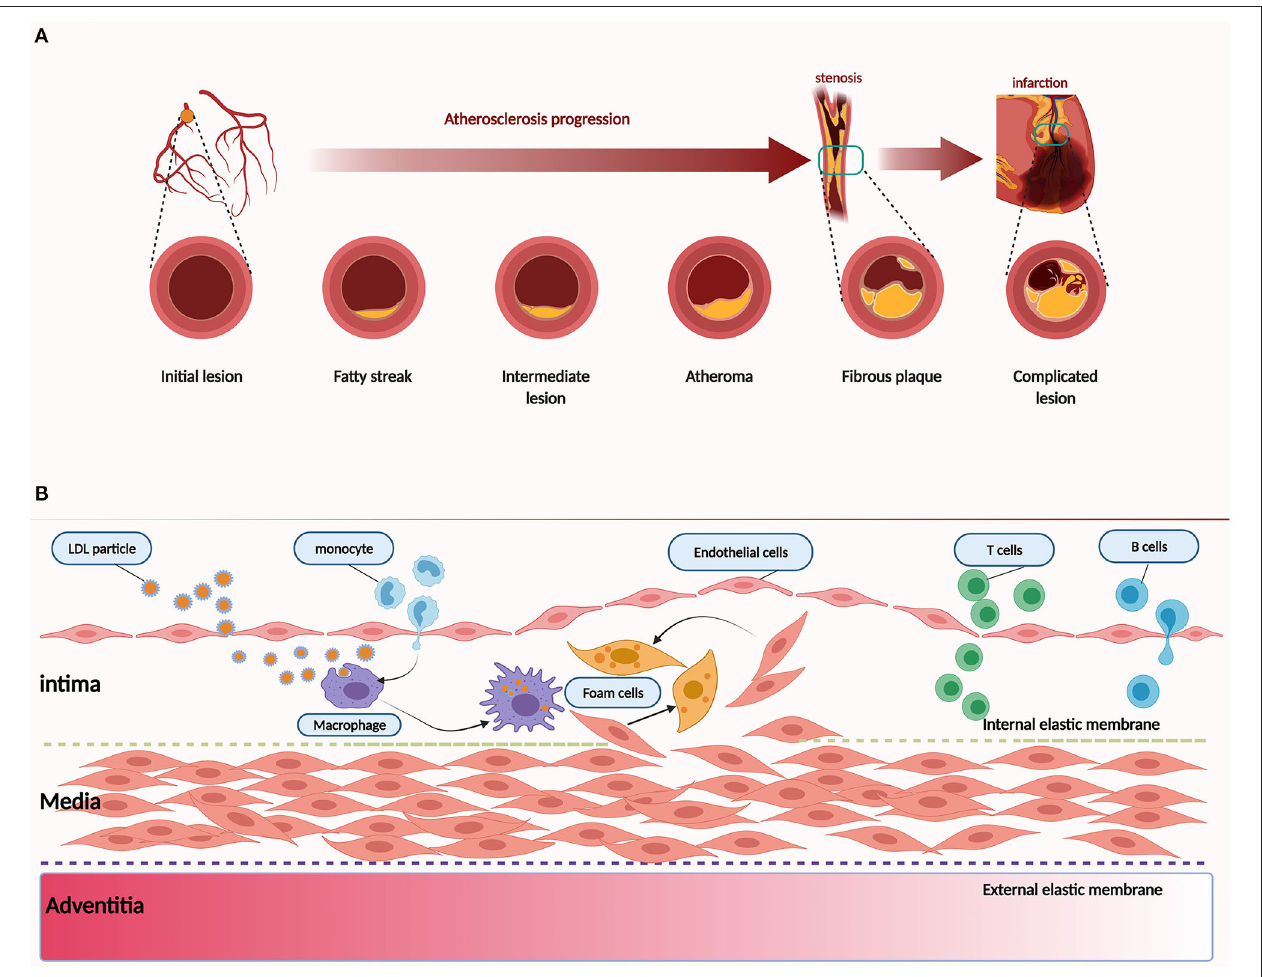
FIGURE 1 | Pathology of atherosclerosis. (A) Atherogenesis stages. (B) Atherosclerosis is a dynamic process. Inflammation is associated with atherosclerosis in different stages. Dysfunction of the endothelium is a primary event in atherogenesis, which can be caused by various risk factors, such as physical stress and chemical stimulants. LDL particles accumulate and are absorbed by macrophages derived from monocytes of blood and smooth muscle cells that migrate from the media to the intima. As another critical step in atherogenesis, leukocytes, such as T and B cells, are recruited to the arterial wall to produce cytokines and direct monocytes to the atherosclerotic